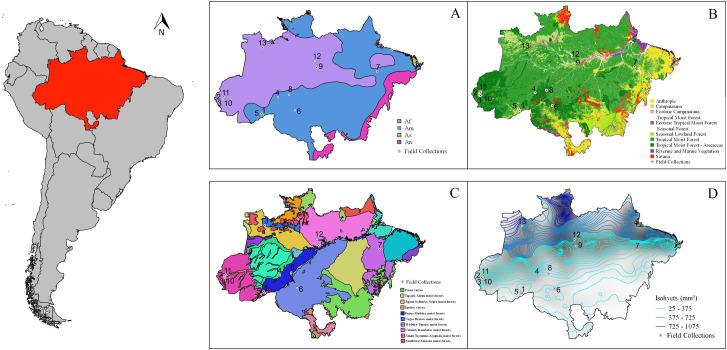
Map of Brazilian Amazonian biome (in red) in South America.A: Köppen and Geiger Climate Classification; Af–Tropical Rainforest, Am–Tropical Monsoon, As–Tropical wet and dry, Aw–Savanna, Cfa–Humid subtropical, Cwa–Subtropical-dry winter. B: Brazilian Vegetation Class (IBGE, 2012); Anthropogenic–dominance of Poaceae, Verbanaceae, Lamiaceae, Solanaceae and Asteraceae botanical families; Tropical Moist Forest–dominance of Lecythidaceae and Vochysiaceae; Tropical Moist Forest Arecaceae–dominance of Lecythidaceae, Vochysiaceae and Arecaceae; Riverine and Marine Vegetation–Arecaceae, Solanaceae, Myrtaceae and Rhizophoraceae; Campinarama–Euphorbiaceae, Arecaceae, Humiriaceae and Fabaceae; Savana–Poaceae, Cyperaceae, Amarylidaceae and Xyridaceae; Seasonal Lowland Forest–Lauraceae, Lythraceae, Boraginaceae, Fabaceae and Myrtaceae. C: Amazonian ecoregions based on biogeography (https://ecoregions2017.appspot.com/) [100]. D: Quarterly Totals Precipitation (mm3) of June, July and August from 1977 to 2006 (http://cprm.gov.br). Reprinted from QGIS version 2.8 without any changes, under a CC BY license, with permission from PLOS ONE, original copyright 2020.